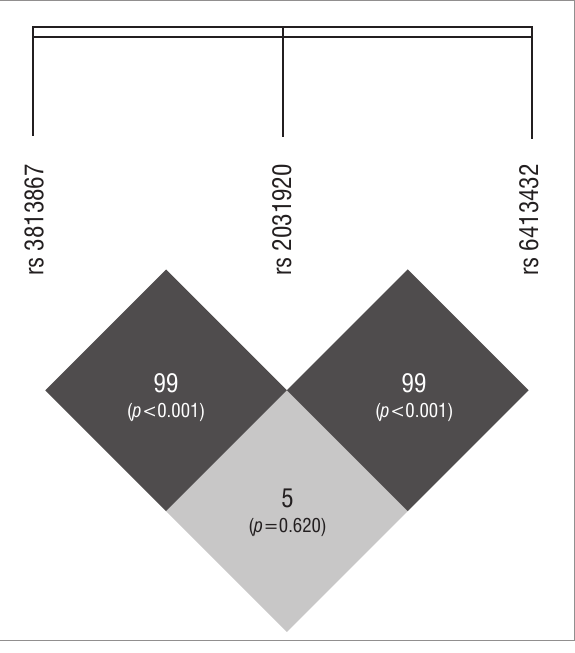
Figure 1: Linkage disequilibrium scores (D’) between rs3813867, rs2031920 and rs6413432 in CYP2E1 . Complete LD is observed where the LD score is 100. Complete linkage equilibrium is observed where the LD score is